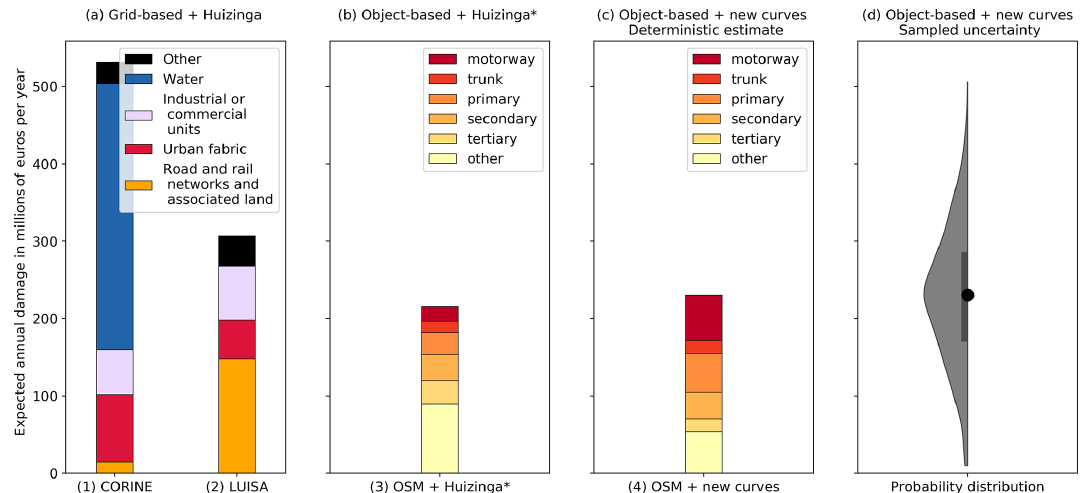
Figure 5. Flood risk of the European road network according to the grid-based and the object-based approach. (a) Grid-based approach with (1) CORINE and (2) LUISA and the Huizinga damage curves, per land cover type. (b) Object-based approach and ∗ object translation of Huizinga damage curves (3), per road type. (c) Object-based approach and new damage curves (4), deterministic estimate per road type. (d) Same as (4) with probability density around the deterministic estimate of (c) , with the black dot indicating the median and the thick line indicating the interquartile